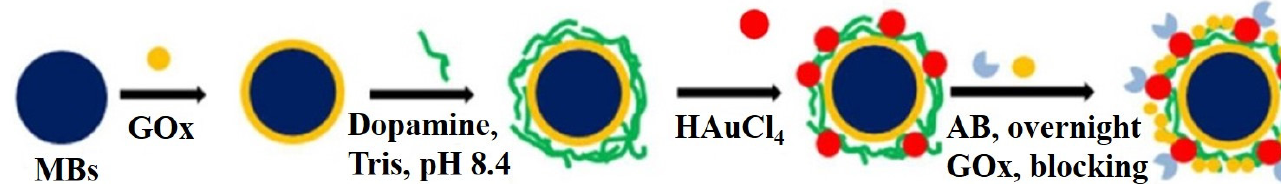
Figure 10. Schematic depicting ABs/GOx ext /AuNPs/MBs–GOx@PDA PMNCs synthesis (adapted and reprinted with permission from [152]).